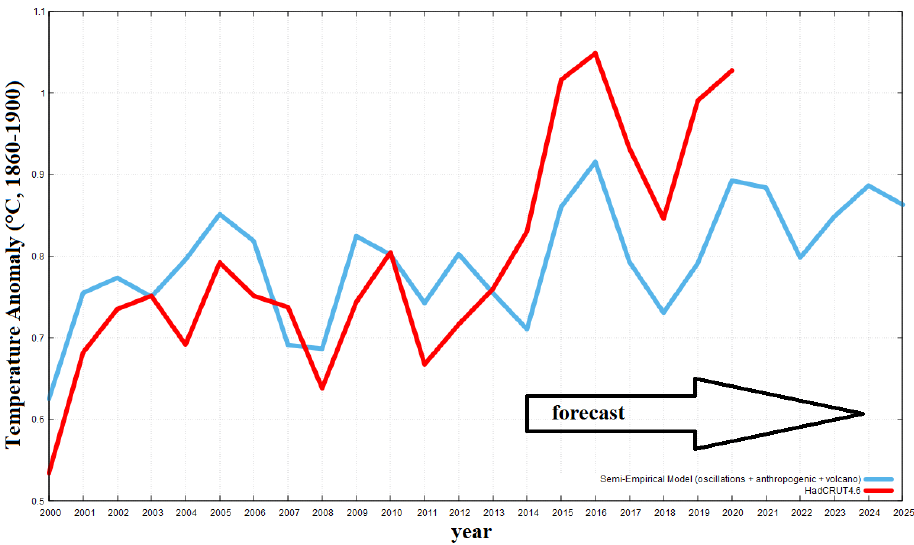
Figure 15. Comparison of the model (blue) against the latest global surface temperature HadCRUT4.6 (red), up to